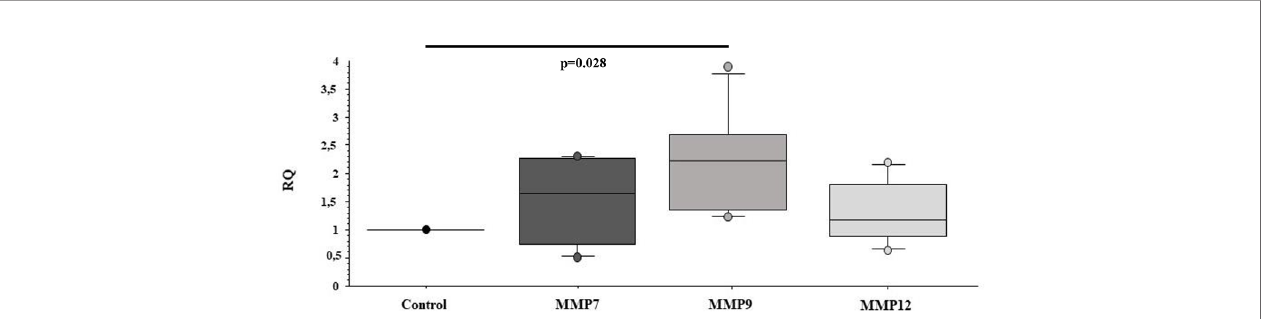
FIGURE 7 | Real Time analysis of MMP genes in naïve M(LPS) THP-1 macrophages treated with sEVs. The M(LPS) THP-1 cells treated with the sEVs PBDE (1:1 concentration) have a statistically signi fi cant increase in MMP9 expression (p=0.028) compared to control cells (treatment with LPS). Boxplot bars indicate (from the bottom to the top) 10 th , 25 th , 50 th (median), 75 th , and 90 th percentiles. Values below the 10 th and above the 90 th percentiles are plotted as circles. Statistical analysis was performed by Wilcoxon signed rank test used for evaluating not normally distributed paired data.